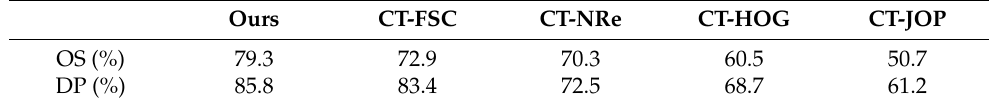
Table 4. Component effectiveness analysis on OTB-50 under one-pass evaluation